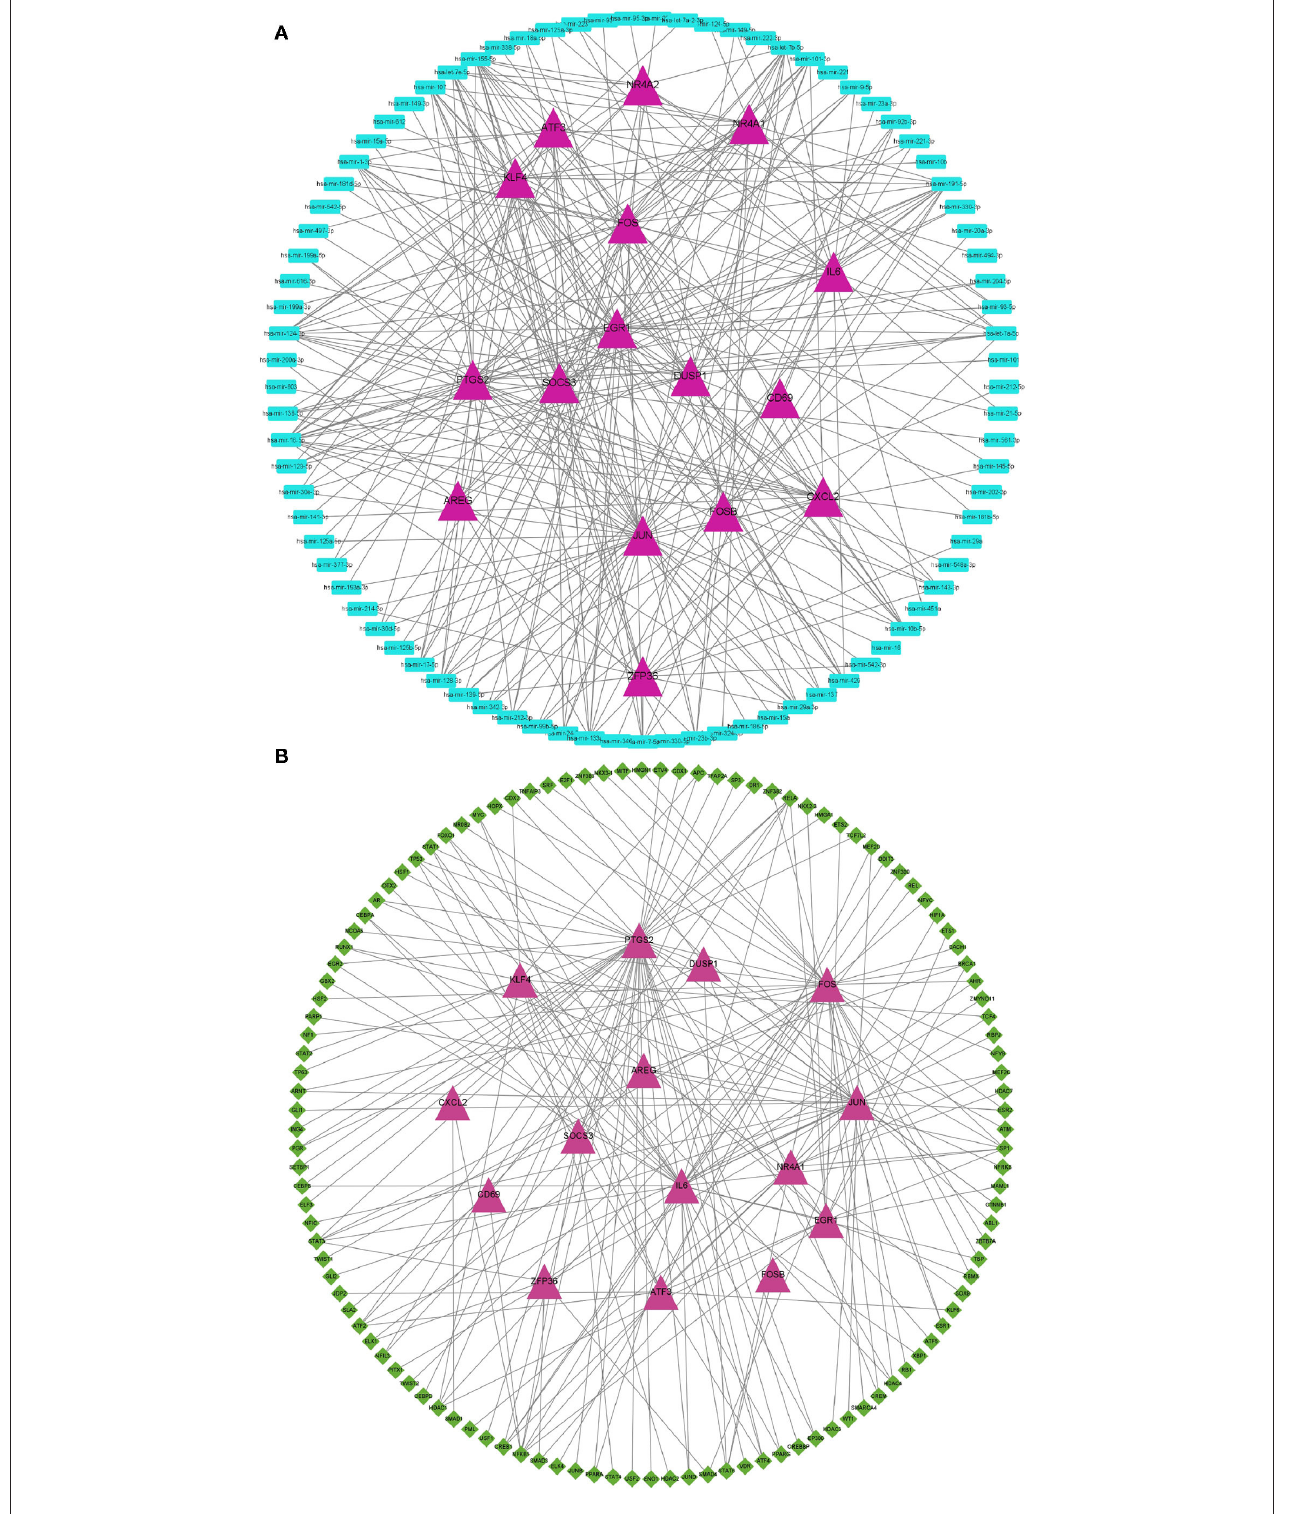
FIGURE 4 | Regulation network of hypoxia-related DEGs in the PPI network. (A) Construction of the miRNA-mRNA network. Hypoxia-related DEGs are represented by magenta triangles, and the corresponding miRNAs are represented by blue triangles. (B) Construction of the TF-mRNA network. Hypoxia-related DEGs are represented by magenta triangles, and the TFs targeting hypoxia-related DEGs are represented by green diamonds.